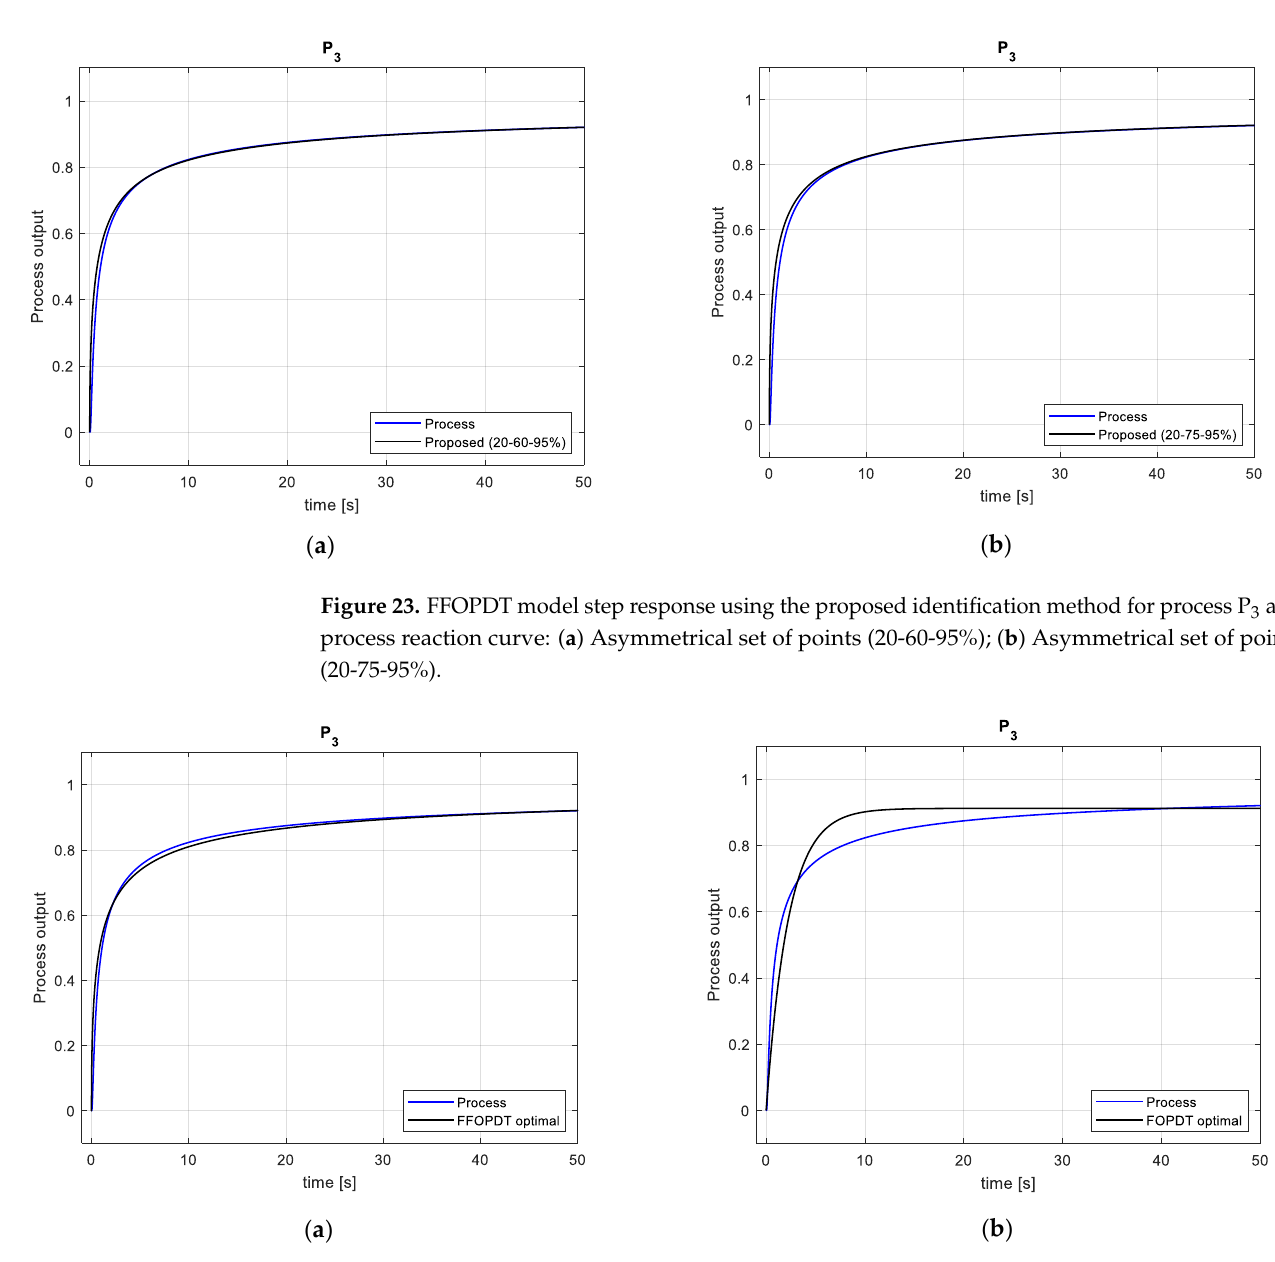
Figure 24. FFOPDT model step response using the proposed identification method for process P 2 and process reaction curve: ( a ) Optimal FFOPDT; ( b ) Optimal FOPDT.